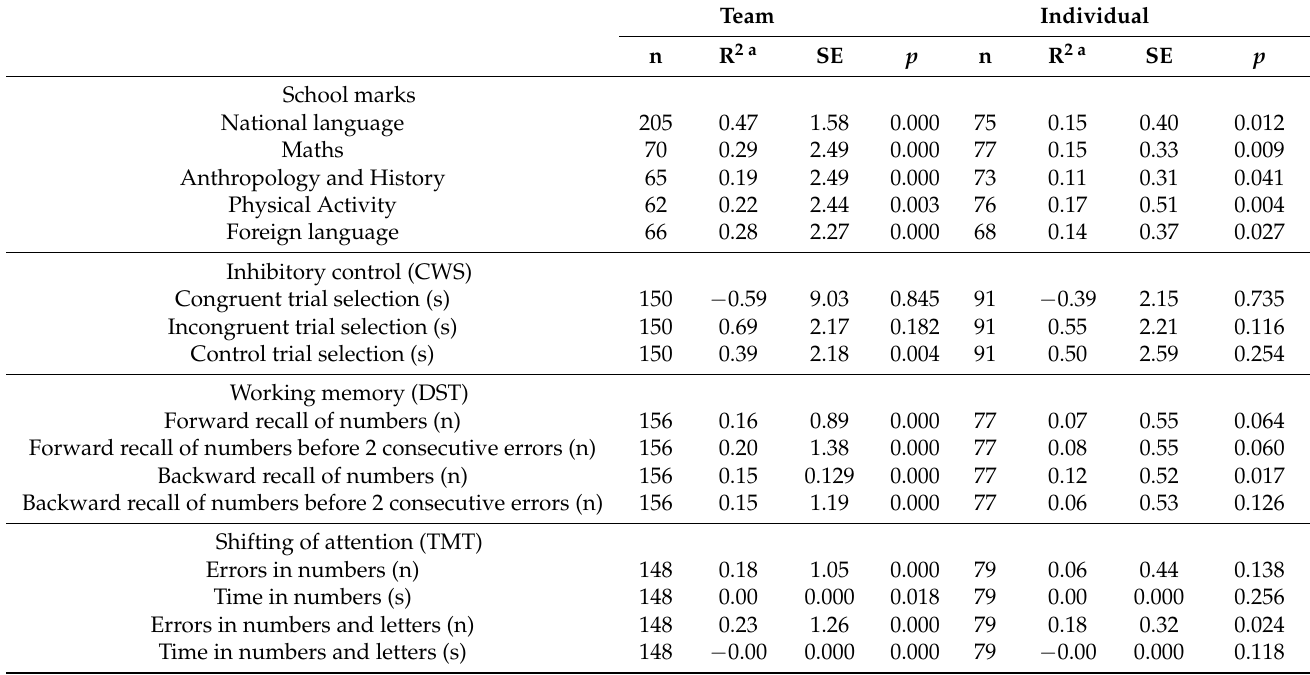
Table 5. Associations between the crunning test performance and cognitive/neuropsychological aspects for team and individual sport